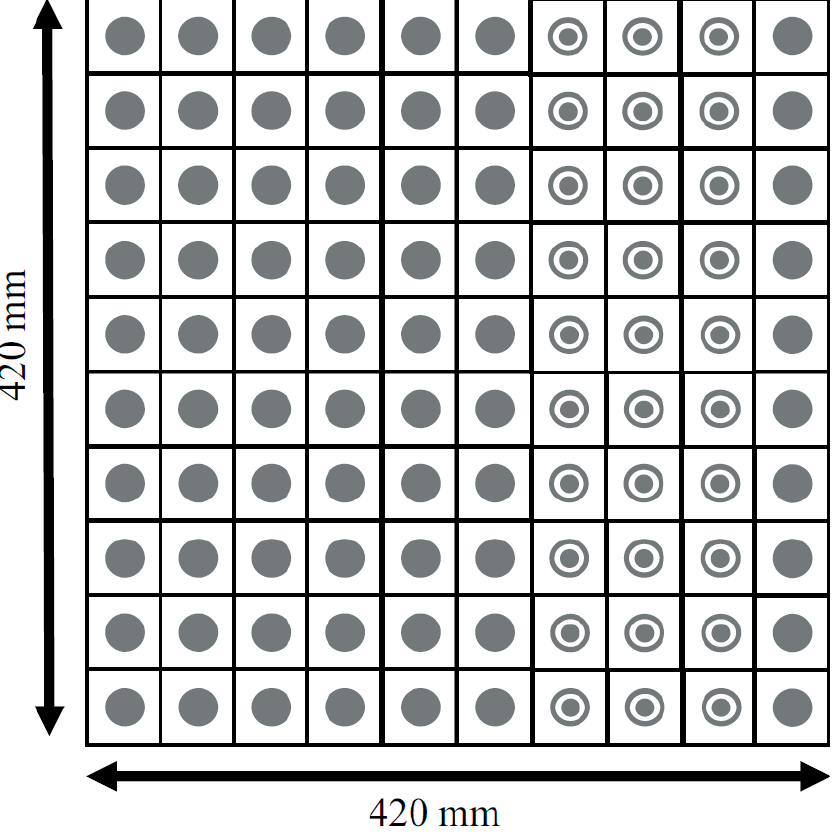
Figure 3. Configuration of the 10 × 10 RIS.